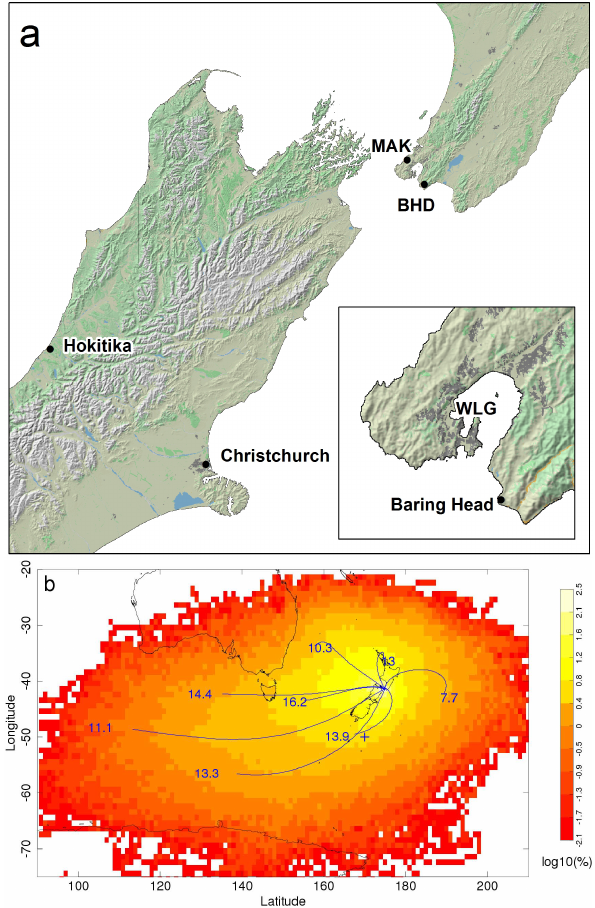
Fig. 1. Maps showing (a) the location of Baring Head (BHD) and other landmarks, and (b) clustered results of 20yr (1988–2007) of twice-daily 4-day back-trajectory calculations, with percentages in- dicated for each cluster. In (a) , labels also indicate Makara (MAK) and Wellington (WLG) on the North Island, and colors indicate forests (green), inland water (blue), populated areas (dark gray), non-forested land (beige), and above tree line (light gray). In (b) , color shading indicates a logarithm of the percentage of trajectories crossing a given latitude/longitude square. The + symbol indicates the location of TM3 model output used for comparison to steady pe- riod data in order to avoid local terrestrial influences in the